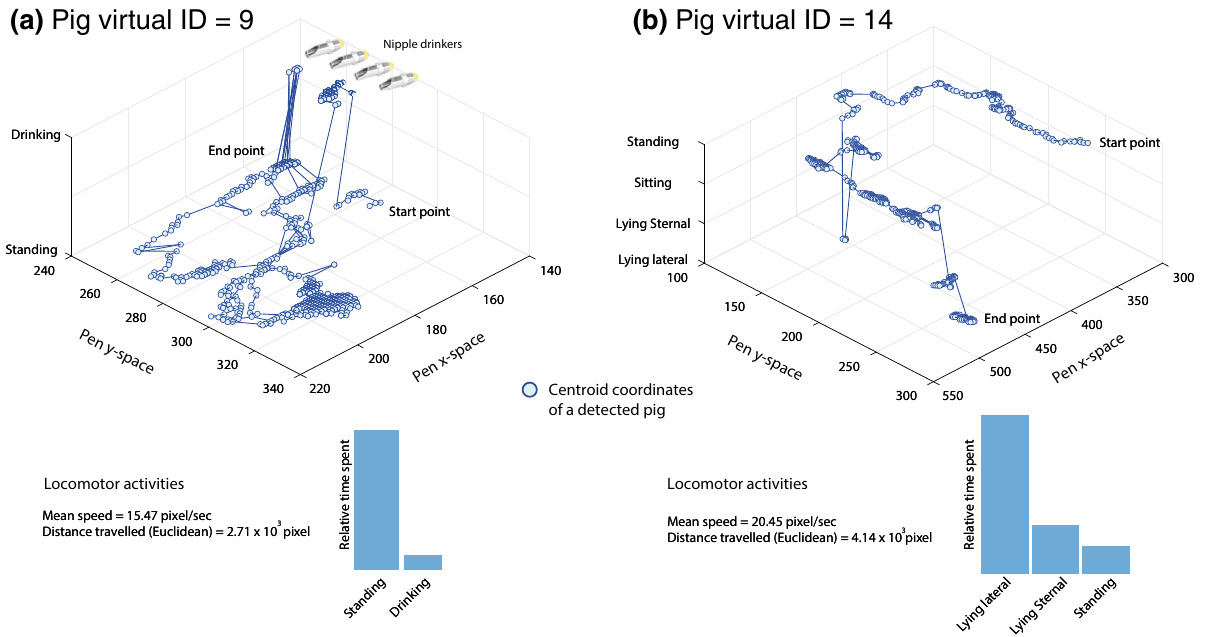
Figure 8. Three-dimensional trajectory of individual pigs: ( a ) vID = 9, ( b ) vID = 14. Each point represents the centroid of the detected pig in the pen x,y space. The z-axis expresses behaviours at each point in time, e.g., drinking, standing, sitting, sternal lying and lateral lying. Bar chart represents the relative proportion of time a pig exhibited a given